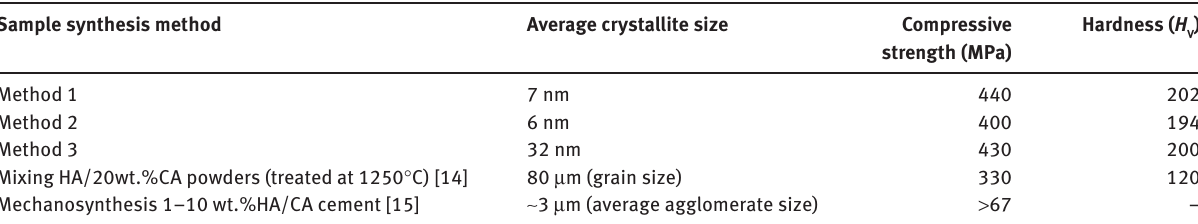
Table 2: Comparison of the structural and mechanical properties of the synthesized HA/CA bioceramic nancomposites and samples reported in previous studies. Sample synthesis